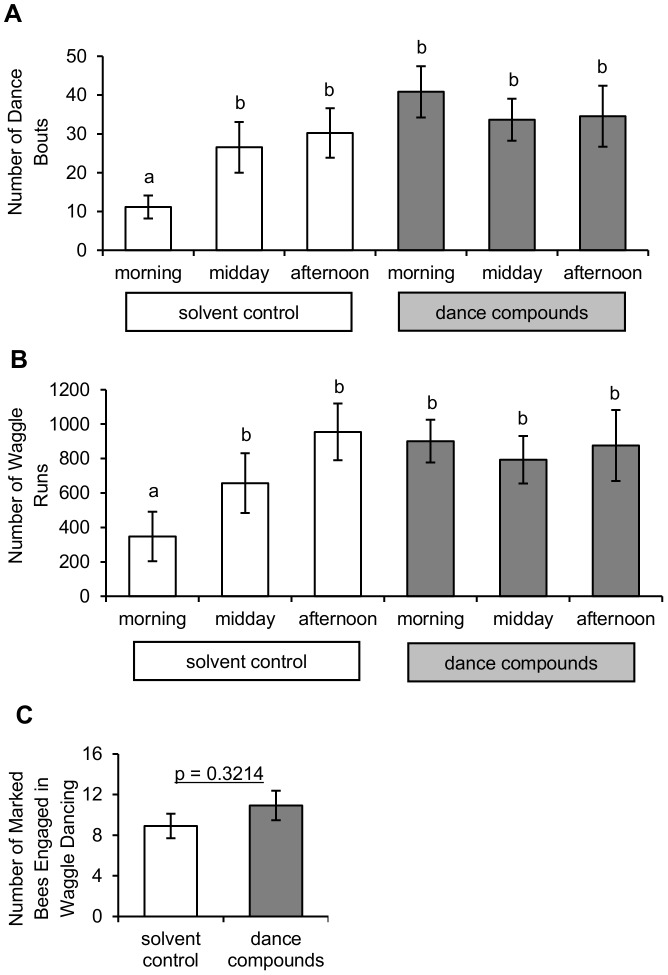
Colony waggle-dance intensity measures following exposure to waggle-dance compounds versus solvent control.The number of waggle-dance bouts (A) and number of waggle runs (B) was significantly higher in dance-compound versus solvent-control trials (linear mixed models; Type III F = 26.66, 6.60; p<0.0001, 0.0139; d.f.  = 1,39; respectively). There was a significant interaction effect between substance type and the time of day during which trials were conducted; fewer dance bouts and waggle runs were observed during morning control trials than during any other type of trial (letters represent significant differences of pairwise comparisons using Tukey-Kramer adjusted p-values, see text for statistics). (C) Dance-compound introduction did not have a significant effect on the number of marked bees engaging in waggle dance behavior (p-value represents a Type III F-test from a linear mixed model, see Table 1). Heights of bars represent untransformed means of 47 trials (A), 49 trials (B), and 44 trials (C); error bars represent the standard errors of these means.